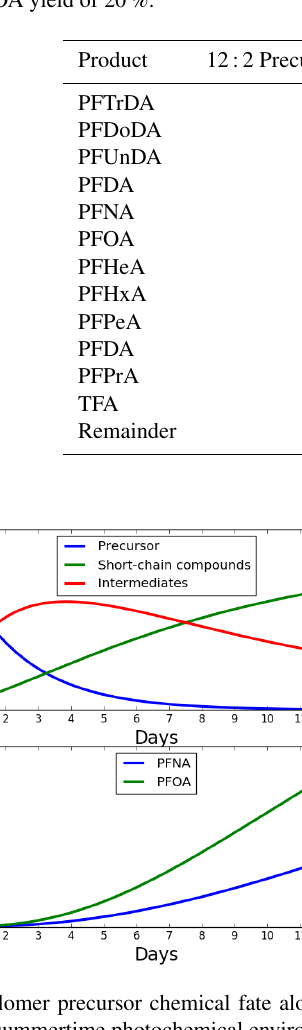
Table 3. Theoretical maximum yield calculations extended to other precursor lengths and product lengths for an environment with PFNA yield of 18 and PFOA yield of 20%.